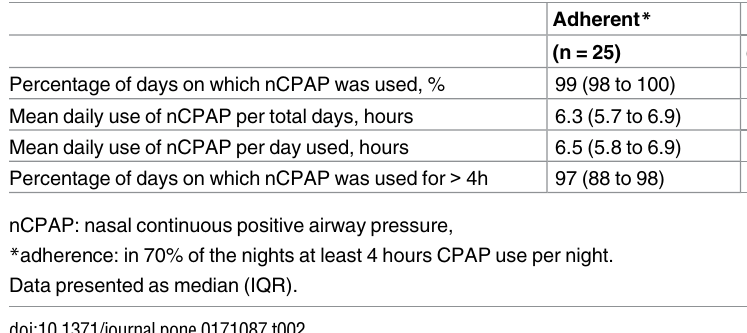
all odour qualities in the non-adherent patients however the change did not reach statistical significance. The TDI scores of the ten non-adherent patients were 33.7 (32 to 34.5) at baseline and 34.9 (33 to 35.5) after three months. In this summarized score statistical significance was also not reached (p = 0.109). The TDI score case profiles and the histogram of TDI score change of the 25 adherent patients are shown in Fig 2. Improvement in TDI-score of (cid:21) 4 was observed in 9 of the 25 adherent patients (36%) and 2 of the 10 non-adherent patients (20%). In the 35 patients, the correlation of self-estimated olfactory performance and TDI score was poor (at baseline R = 0.057, p = 0.743 and after three months R = 0.249, p = 0.148, respec- tively). No statistically significant correlation of change of TDI-score after three months and mean daily use of nCPAP per total days was found (R = 0.25, p = 0.141). Eleven out of the 25 adherent patients agreed to take part in the randomized three weeks CPAP-withdrawal trial. TDI case profiles of the six therapy withdrawal patients and the five therapy maintenance patients are graphically shown in Fig 3.